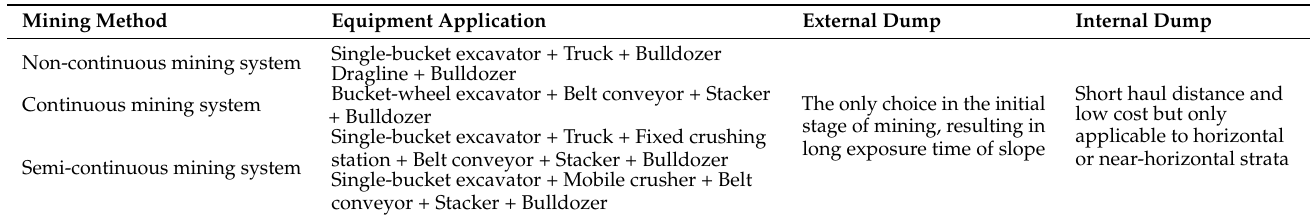
Table 1. Mining methods applied on coal mine excavation-backfilling